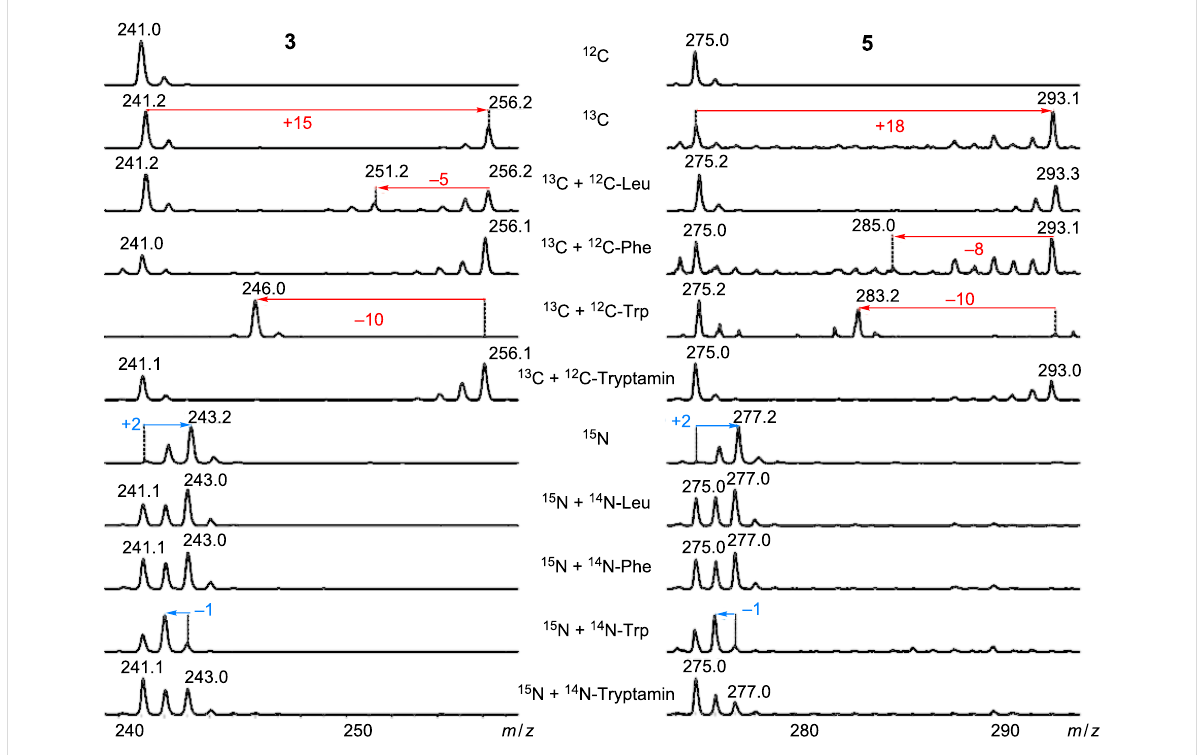
Figure 2: MS data from strain PB22.5, which was cultivated in [U- 13 C] and [U- 15 N] medium background and LB medium as a control. Feeding experi- ments with 12 C and 14 N amino acids confirmed structures 3 and 5 and gave initial insights into the biosynthesis.